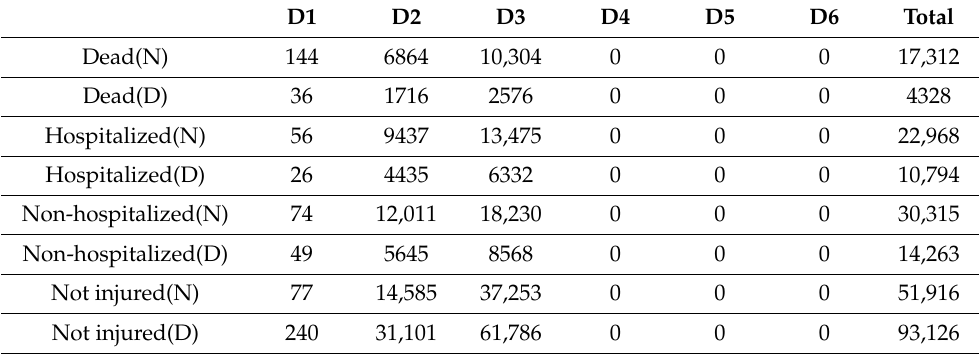
Table 24. Number of casualties in the 1780 earthquake in District 5 of Tabriz.